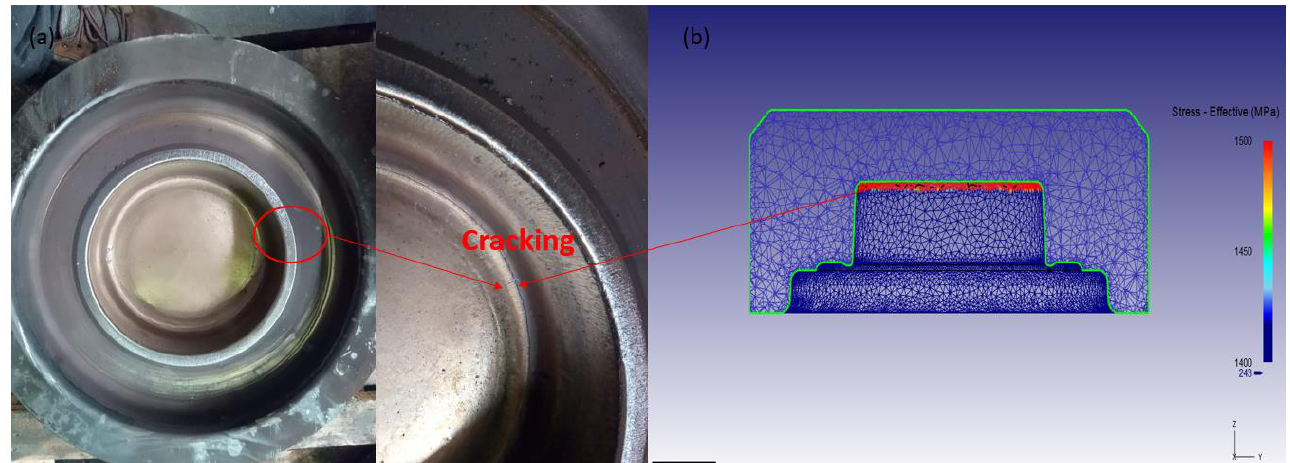
Figure 12. Comparison of cracking with stress distribution: ( a ) Actual top die showing crack, ( b ) Effective stress distribution in the top die (cross-section).